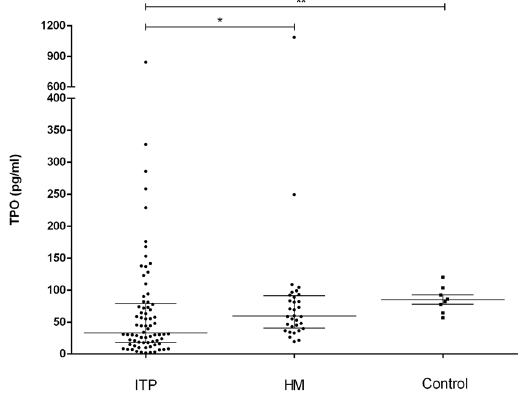
Figure 3. Thrombopoietin (TPO) levels were measured by ELISA in patients with immune thrombocytopenia (ITP; n = 74) and hereditary macrothrombocytopenia (HM; n = 27). Eight ITP patients in complete remission for at least one year and off any treatment were evaluated as a control population. Horizontal bars represent: medians and interquartile ranges. Kruskal-Wallis test with Dunn’s post test; * P = 0.04 and ** P = 0.03.